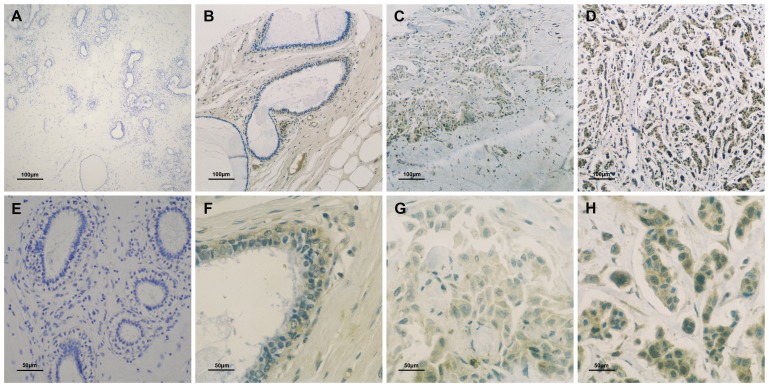
Immunohistochemistry analysis of BCOX1 expression.The BCOX expression in individual breast carcinoma tissue samples and the corresponding non-tumor tissues was characterized by tissue microarray and immunohistochemistry using specific antibody. Data shown are representative images (magnification×200 or 400) from 491 paired of IDC breast tissues. A and E: Negative staining for anti-BCOX1 in non-tumor breast tissues (A,×200; E,×400); B and F: Low levels of BCOX1 expression in non-tumor breast tissues (B,×200; F,×400); C and G: Low levels of BCOX1 expression in breast carcinoma tissues (C,×200; G,×400); D and H: High levels of BCOX1 expression in breast carcinoma tissues (D,×200; H,×400).